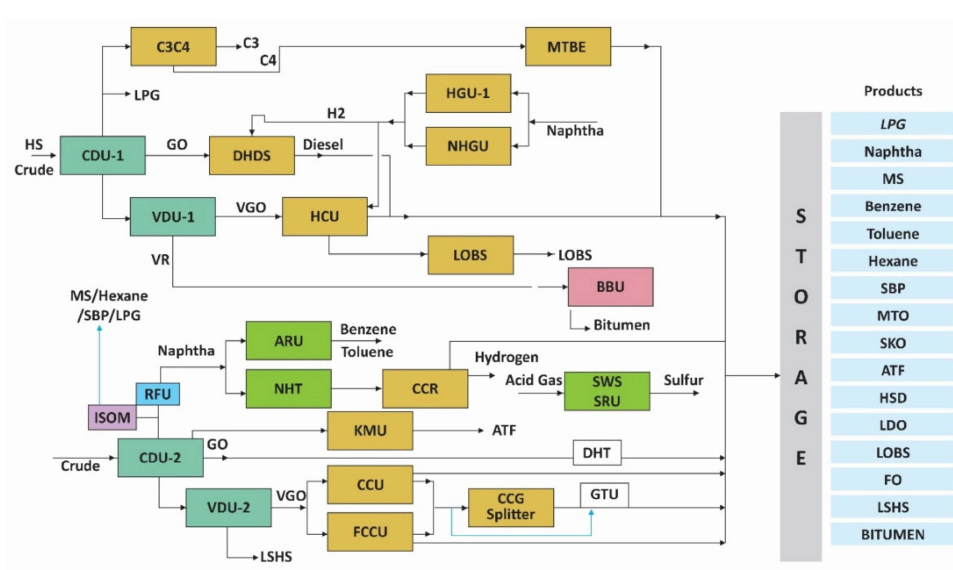
Figure 3. Block flow diagram of refinery